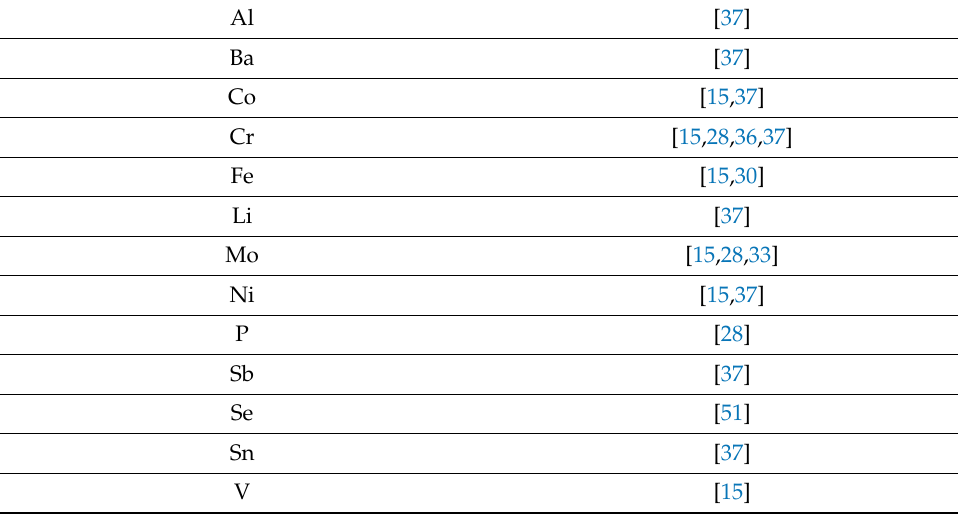
Table 5. Metals considered by author: less studied.